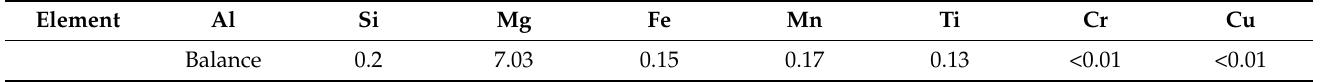
Table 1. Chemical composition of an A535 Al-Mg casting alloy (wt.%).